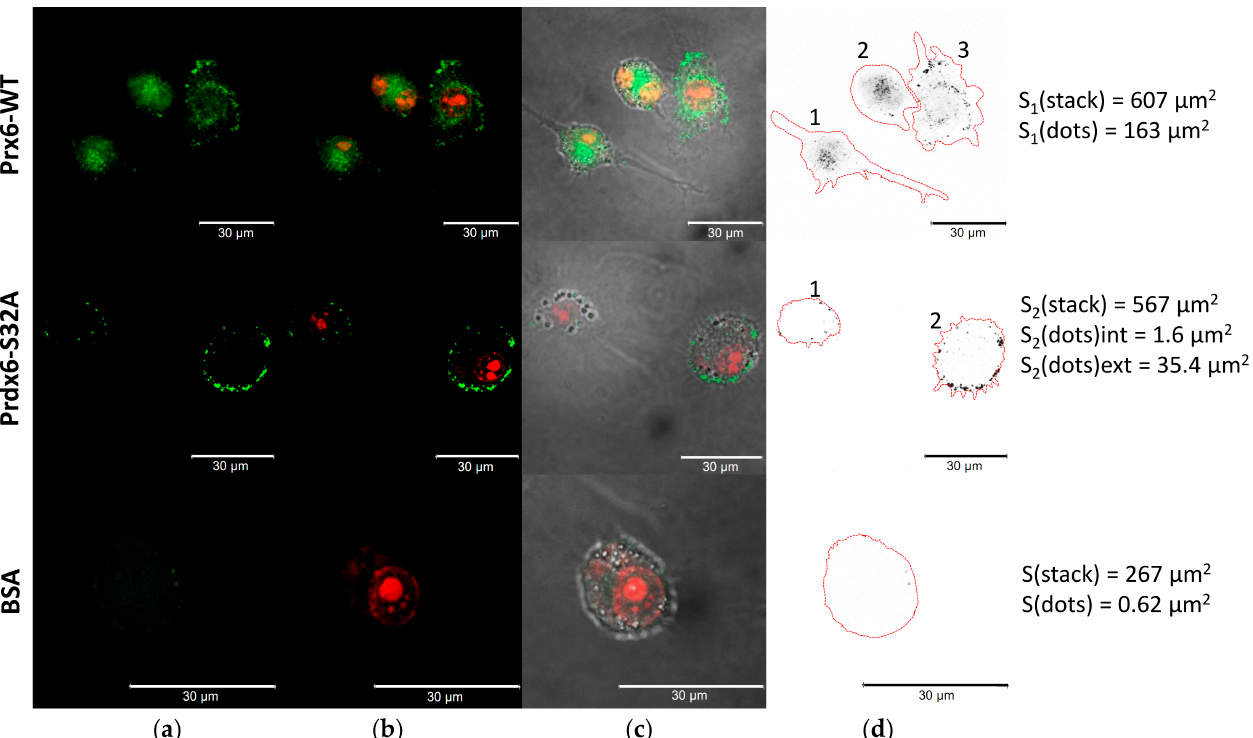
Figure 5. Penetration of exogenous Prdx6 (WT and S32A) into RAW 264.7 cells. ( a ) FAM channel (green) corresponds to FITC-labeled proteins; ( b ) Texas Red channel (red) is aligned with the FAM channel and marks ethidium bromide-stained genomic DNA; ( c ) superimposition of FAM + Texas Red + phase contrast; ( d ) the number of cells in the field of view and areas analyzed in ImageJ are marked, cell contours are shown in red, stack areas and areas with labeled proteins (dots, int–inside the cells, ext–on the cell surface) are shown for the corresponding cells. Scale bars are 30 μ m.